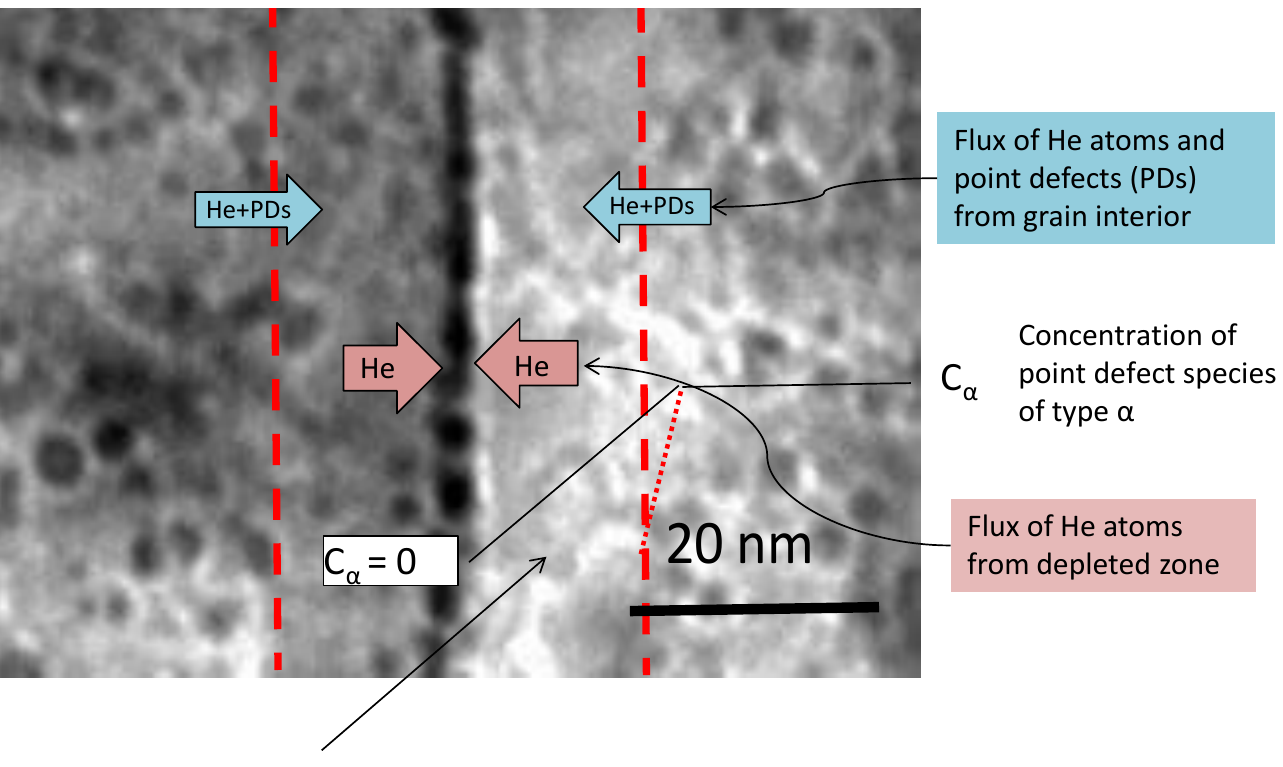
Figure 10. Micrograph illustrating cavity structure in neutron-irradiated Inconel X-750 and the source of He flow to grain boundaries taking into account any denuded zone. The He diffusing to the grain boundary comes from two sources: (i) the denuded zone where there is no trapping by matrix cavities; (ii) the grain interior where the flux is dependent on the internal sink structure. The red dotted line denotes the concentration profile up to the boundary that would normally exist for an irradiated material without a denuded zone, denoted by the red dashed line.